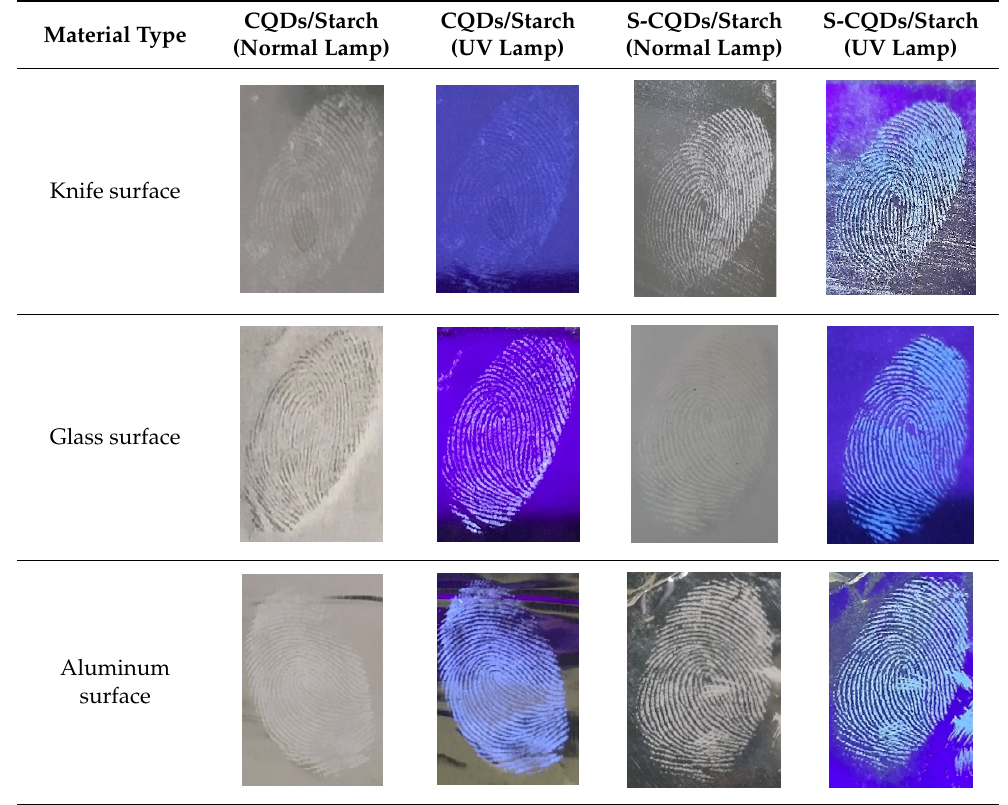
Table 1. Detection on non-porous surface material using S-CQDs/starch vs. CQDs/starch under normal and UV lamps.